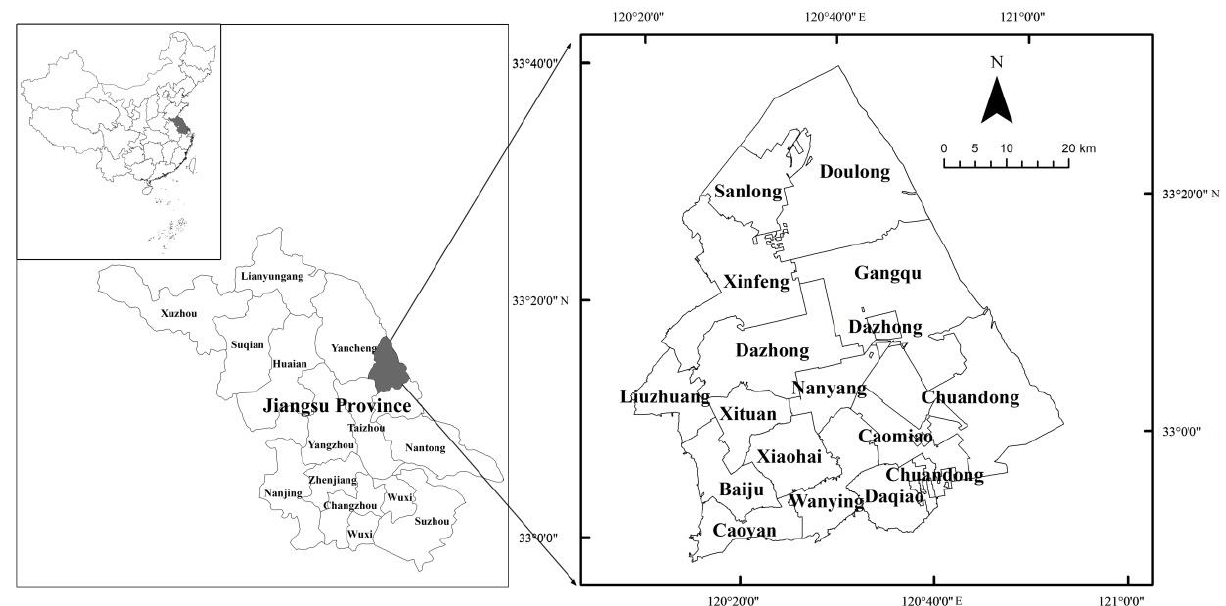
Figure 1. Location of Dafeng District.